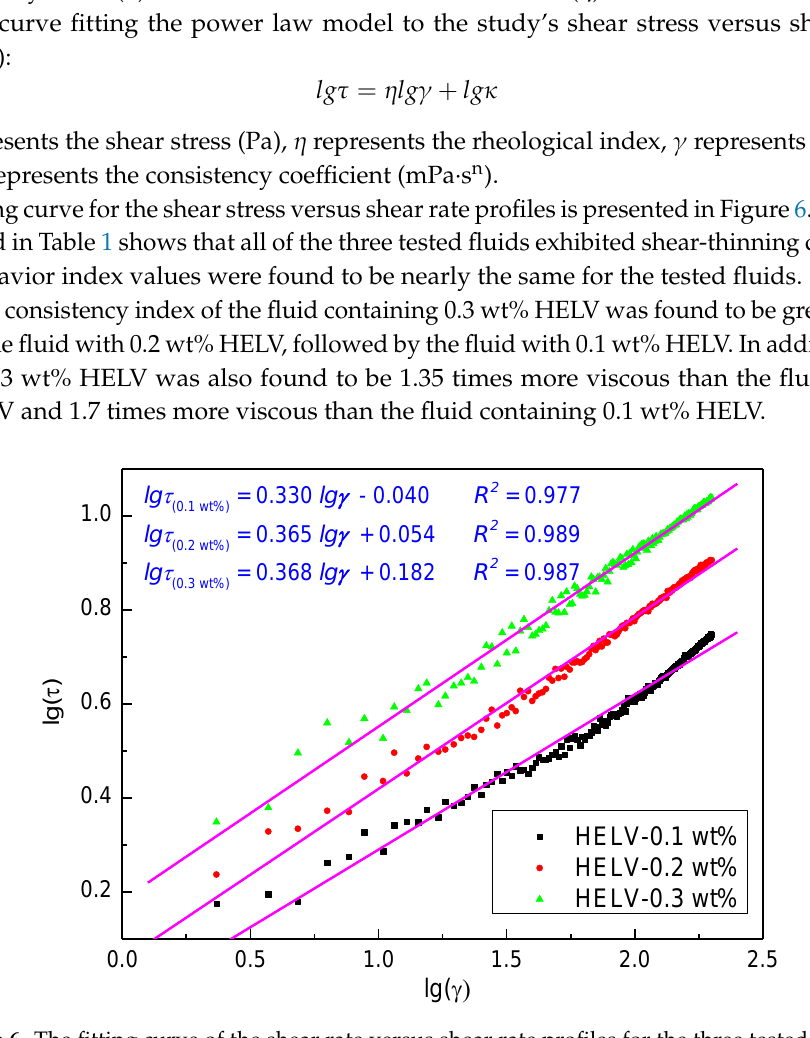
Figure 6. The fitting curve of the shear rate versus shear rate profiles for the three tested fluids. Table 1. The power law model parameters for κ and η for the three tested fluids.